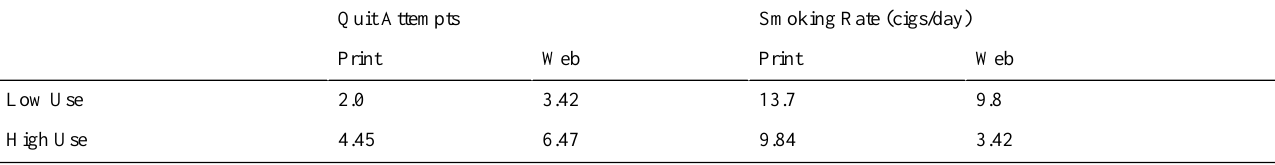
Table 4. Quit attempts and smoking rate at follow-up among high/low intervention users.